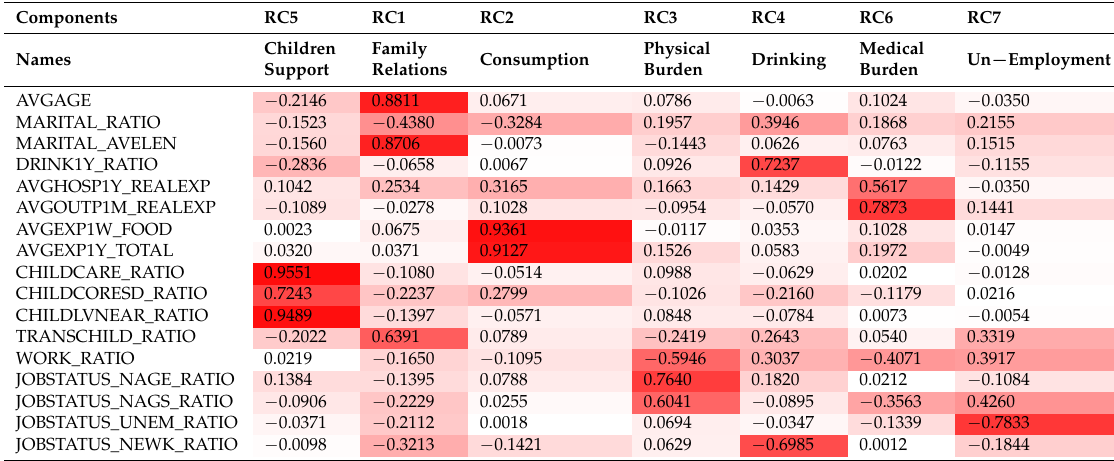
Table A5. Component loadings ( CHRONIC_RATIO